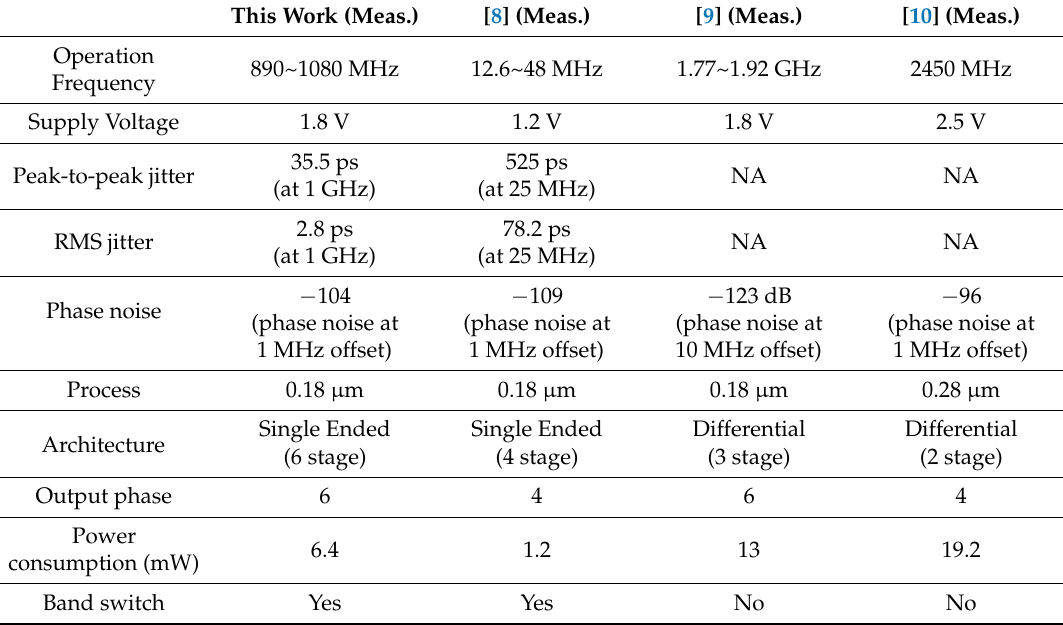
Table 1. A comparison of the proposed VCO to other existing VCOs.